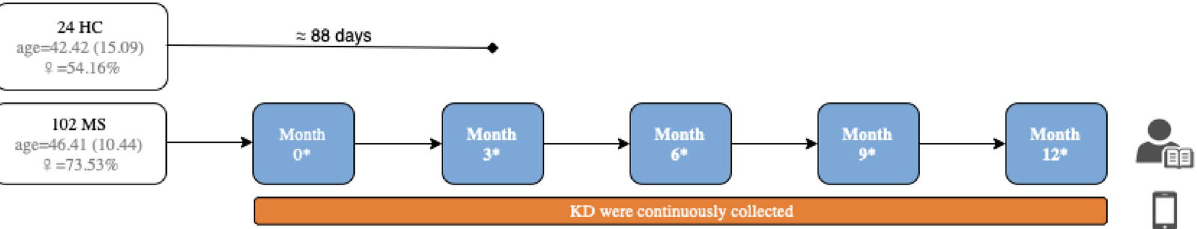
Figure 1. Graphical visualization of the study design. The MS patient group consisted of 102 subjects with MS and the HC group included 24 healthy subjects without any sign of MS. The study consisted of five clinical visits, collected at baseline ( m 00) and then at three-month intervals following baseline ( m 03, m 06, m 09, m 12) for pwMS. Each clinical visit included the collection of the following clinical outcomes measures for the MS patient group: SDMT, NHPT, and